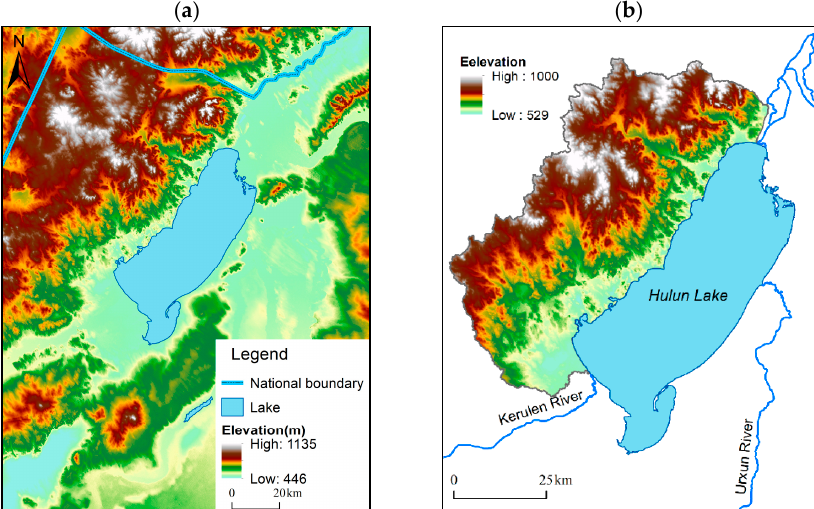
Figure 7. The surrounding topography of Hulun Lake and the area where the slope confluence can flow into the lake. ( a ) Surrounding topography of Hulun Lake, and ( b ) distribution of slope confluence.